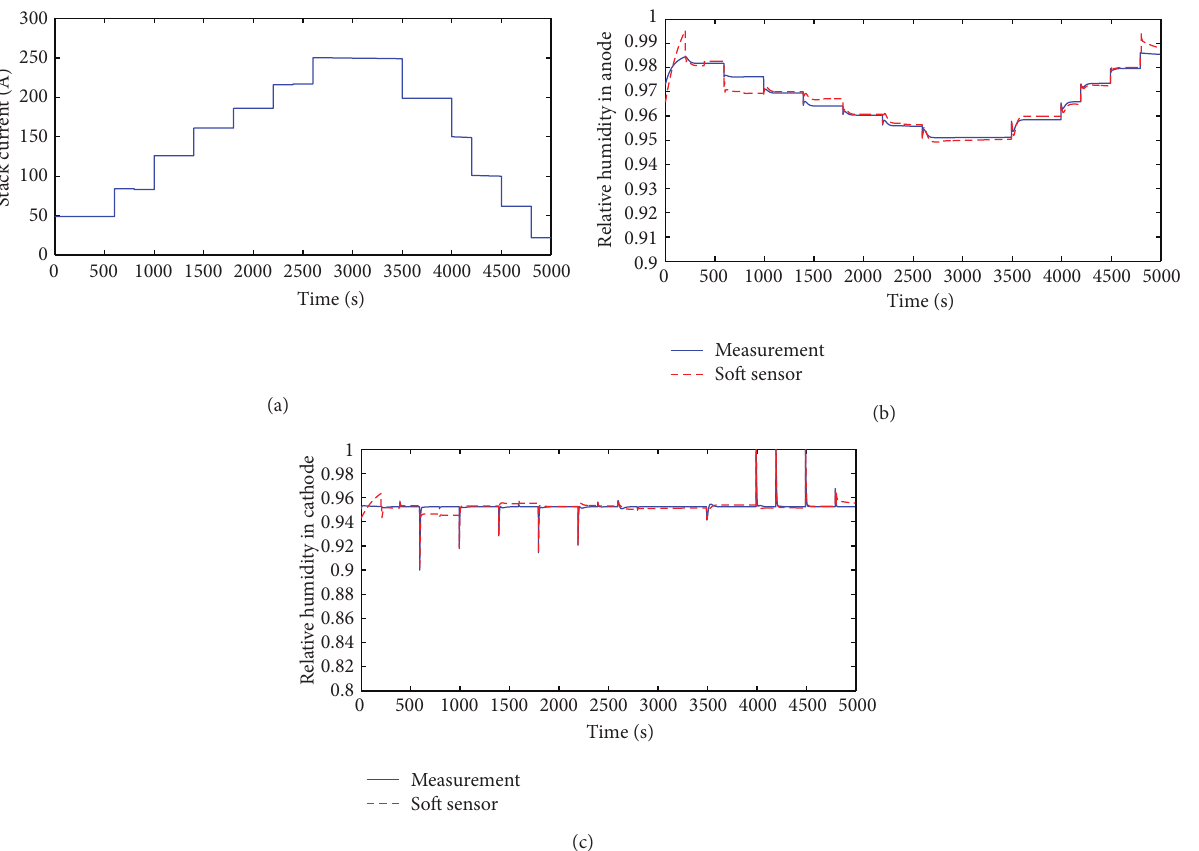
Figure 10: Comparison of measured and soft sensor’s relative humidity with multiple stepped change of stack current. (a) Stack current 𝐼 (b) anode; (c) cathode.